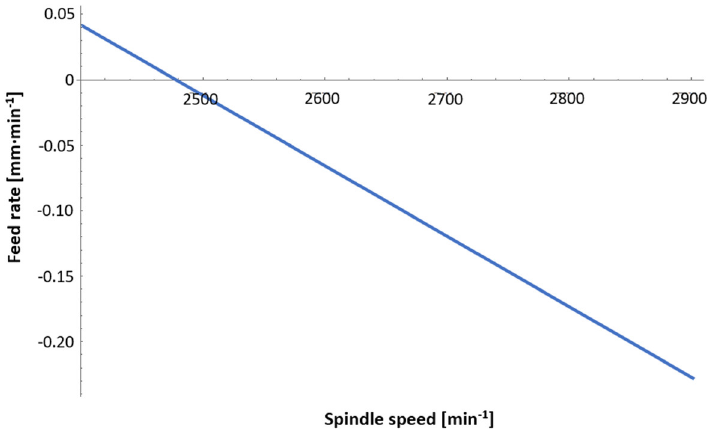
Figure 15. The course of the first derivation of dependence of the number of drilled holes up to the moment of tool damage and speed change.